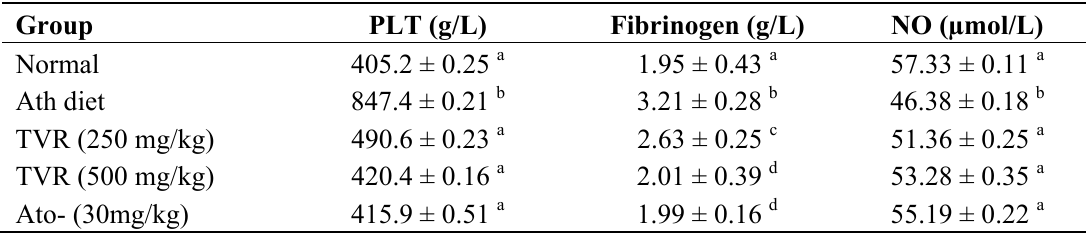
Table 3. Effect of TVR extract on markers of endothelial dysfunction in diet-induced atherosclerogenic